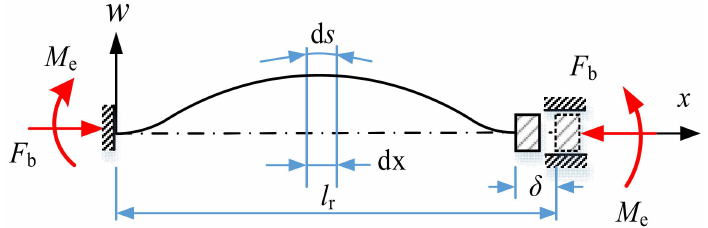
Figure 3. Instability form of the buckling-plate with fixed